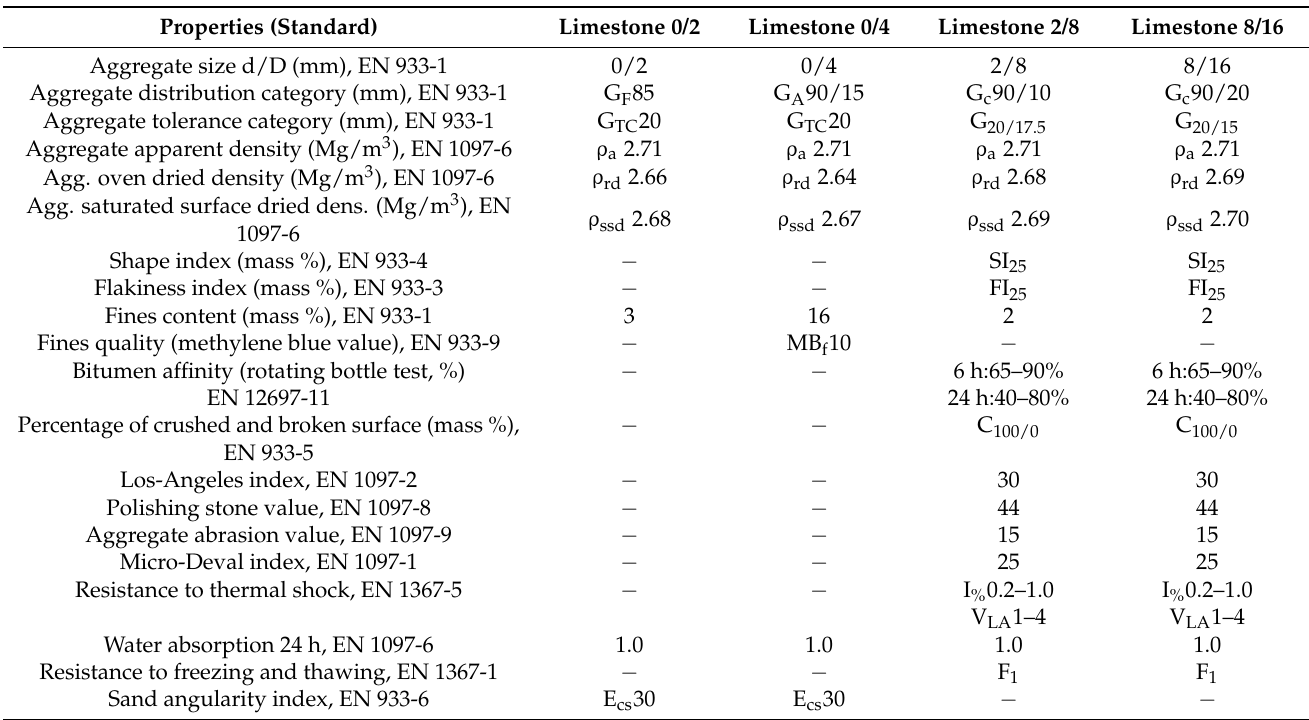
Table A3. Properties of limestone aggregate used in “W” type mixes (results by the